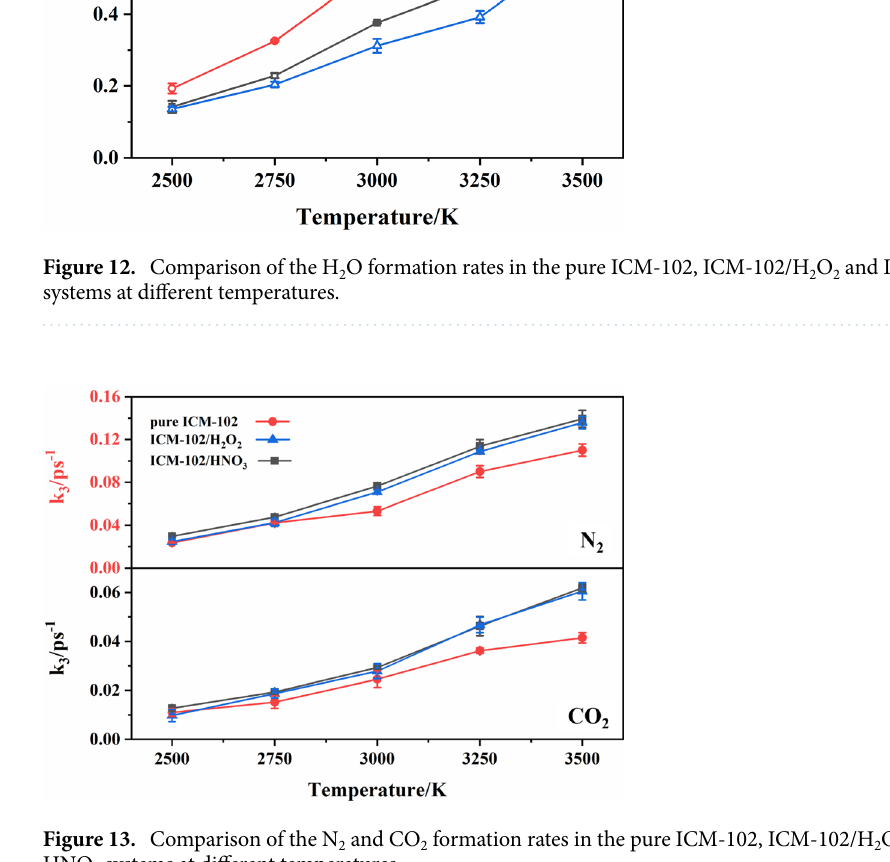
Figure 13. Comparison of the N 2 and CO 2 formation rates in the pure ICM-102, ICM-102/H 2 O 2 and ICM-102/ HNO 3 systems at different